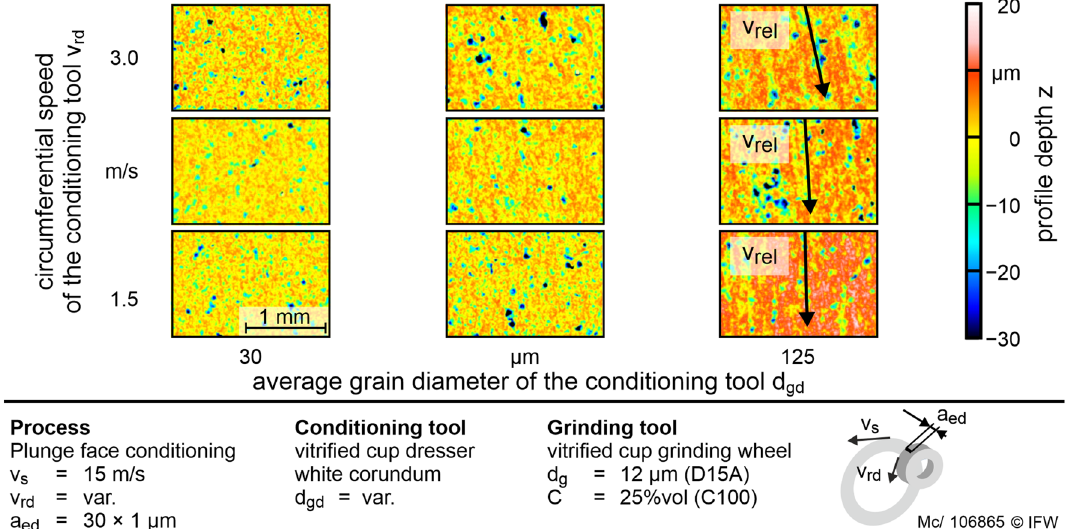
Figure 6. Influence of the circumferential speed and the average grain diameter of the cup conditioning tool on the grinding layer topography. The conditioning grain diameter d gd = 125 µm generates deep groves on the